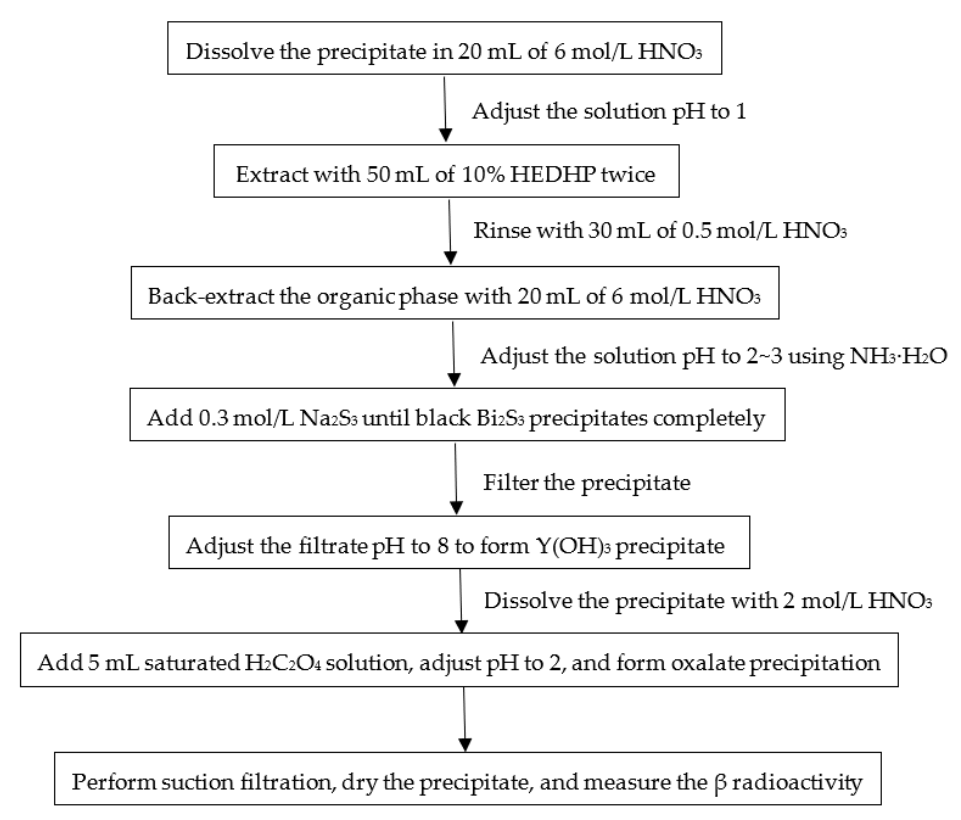
Figure 2. Separation and purification procedure of 90 Y in marine biota